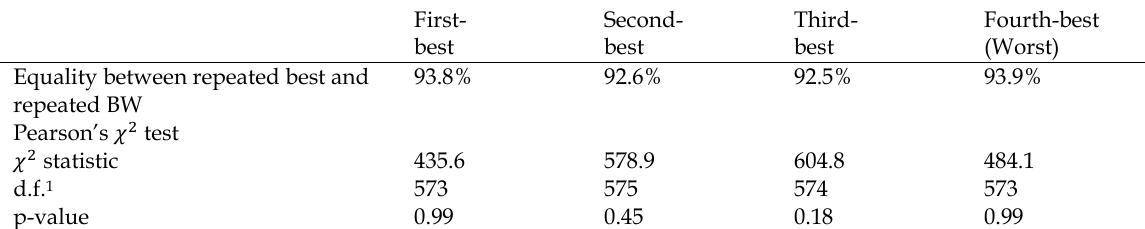
Table 4. Comparison of preference orderings between repeated best and repeated